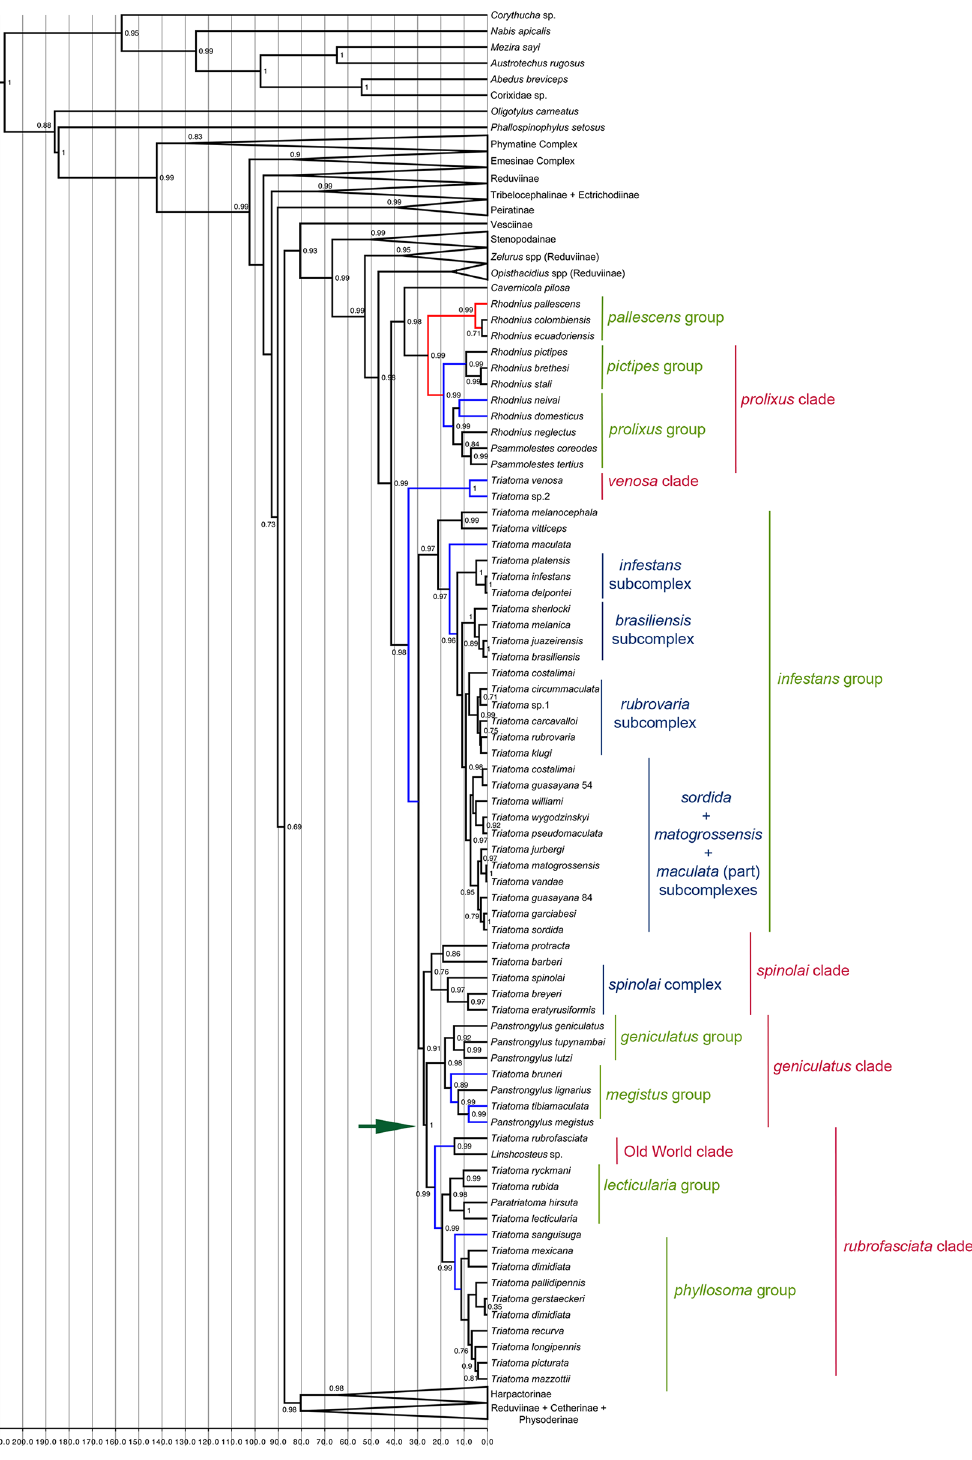
Fig 1. Bayesian phylogeny obtained with six fossil calibrations (B2). Numbers above branches indicate posterior probabilities greater than 0.50. Red branches indicate the cladogenetic events tested based on the literature. Blue branches indicate vicariant events recovered in our analyses and tested. Green arrow indicates the Triatominae fossil calibration